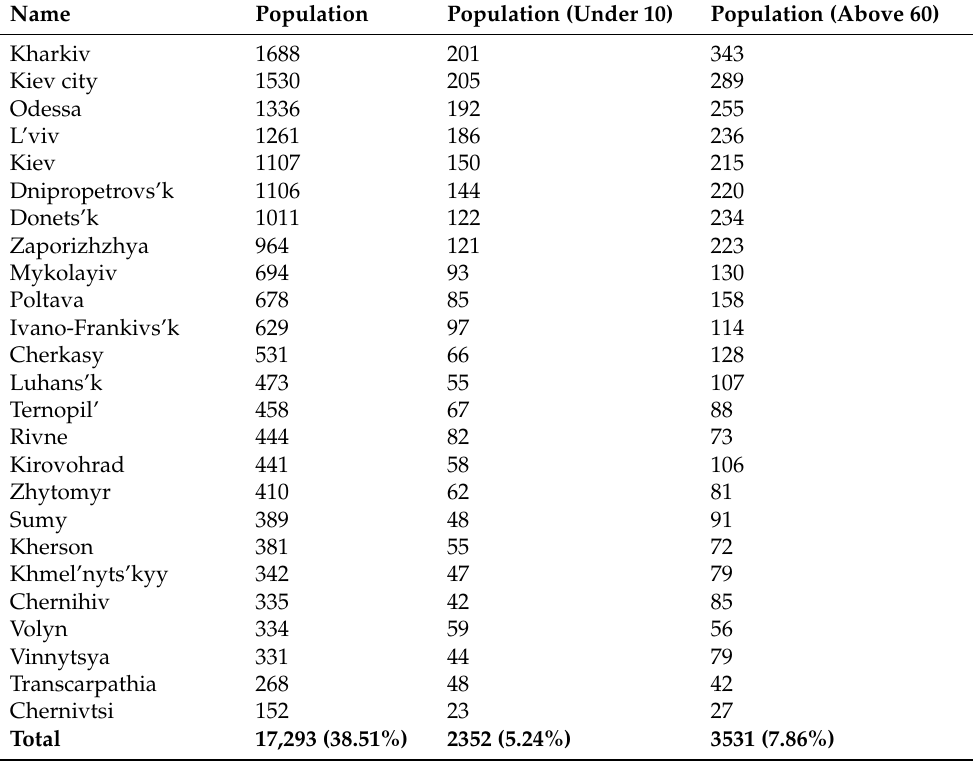
Table 1. Estimated population affected by power shortages (in